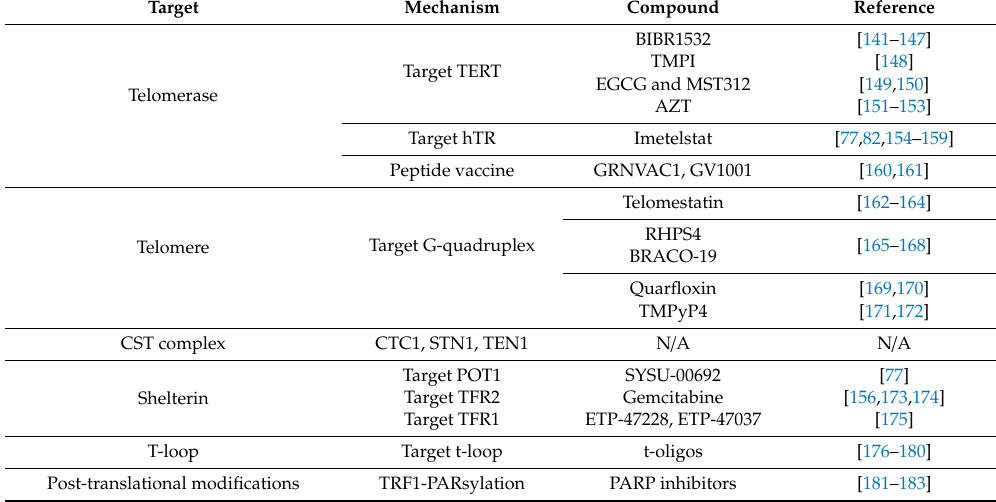
Table 2. List of important small molecule inhibitors and their mechanism of